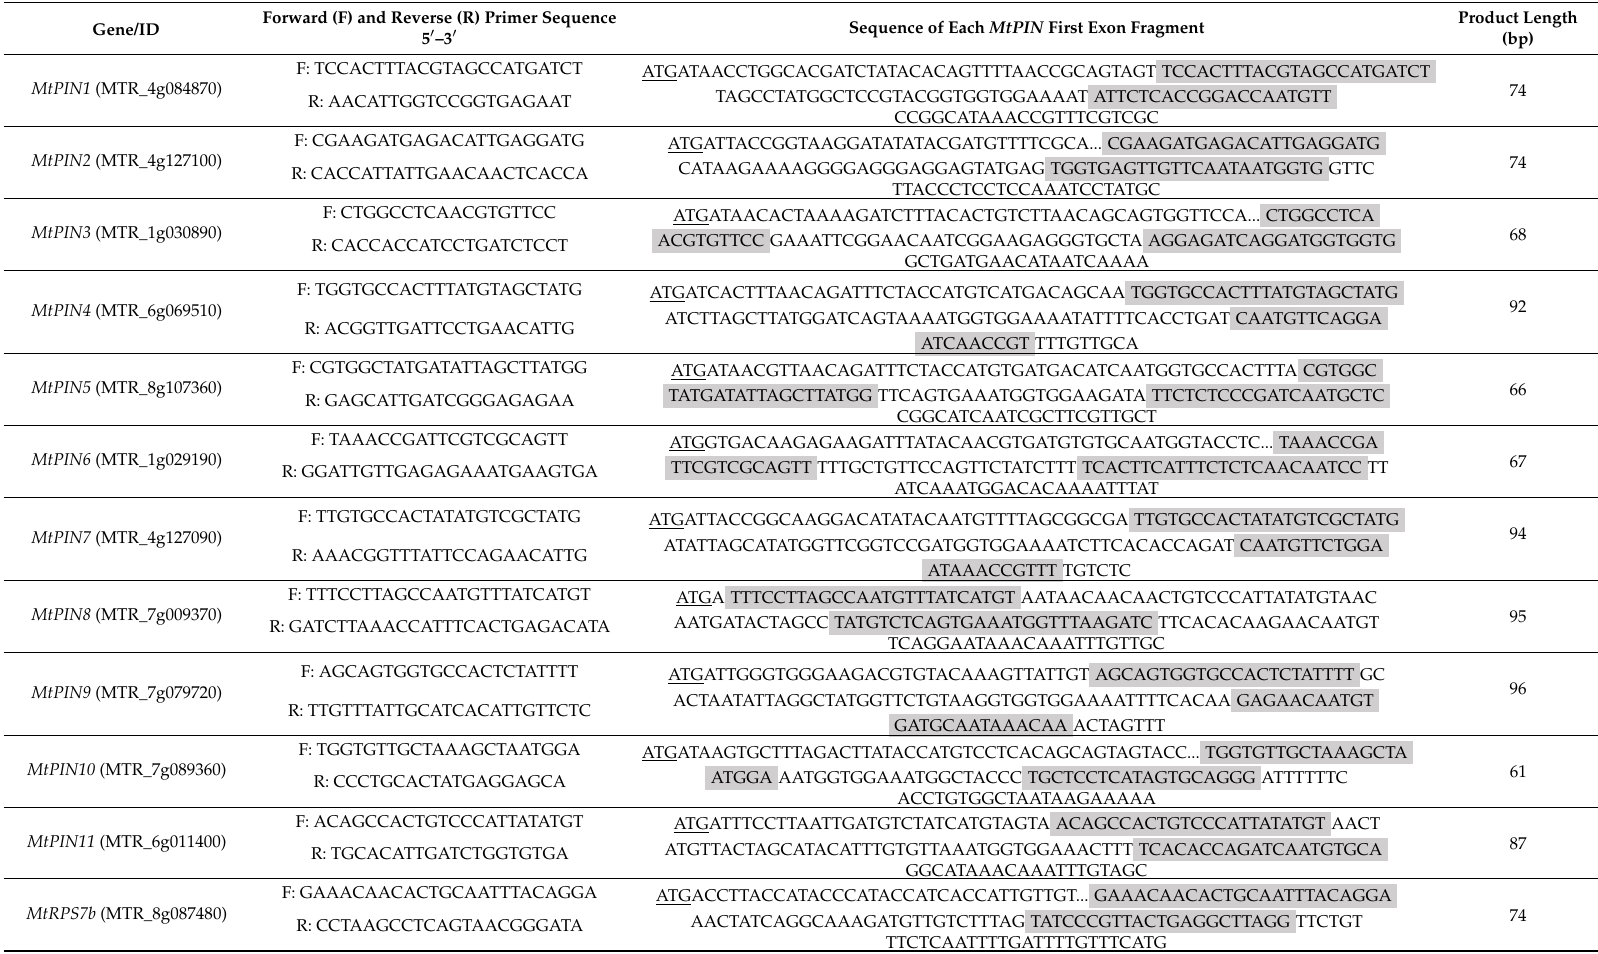
Table 4. Accessions of genes and primers sequences used for real-time qPCR. The exact sequence of each MtPIN first exon fragment that was used for the primer design is also shown (primers binding sites are marked by shading). Underlines represent start codon of each PIN gene and dots ( . . . ) represent the discontinuity within the sequence. bp: base